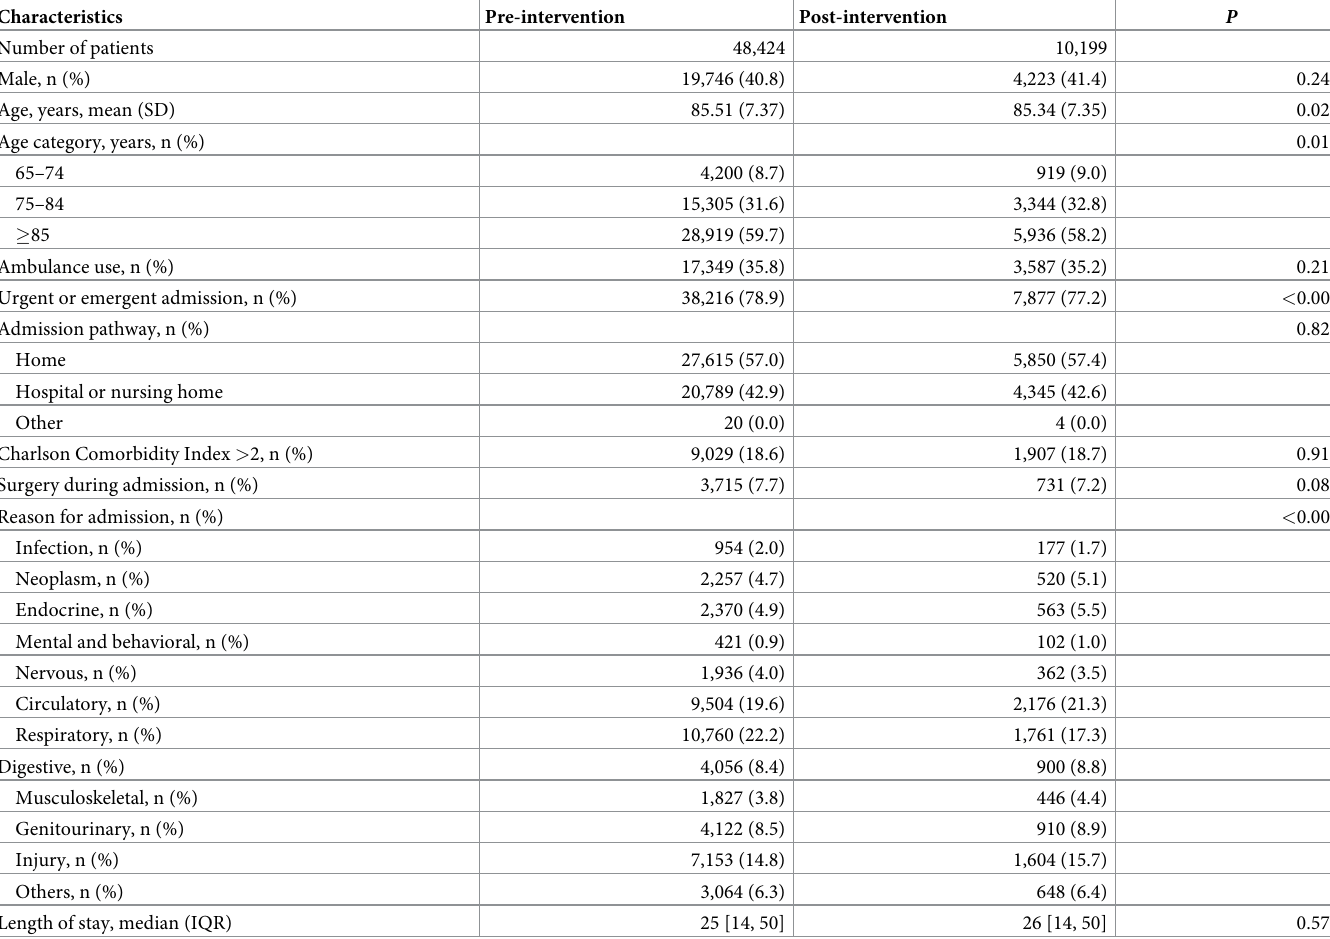
Table 2. Characteristics of patients who received dementia care before and after COVID-19-related regulatory changes in hospitals that received no COVID- 19-positive